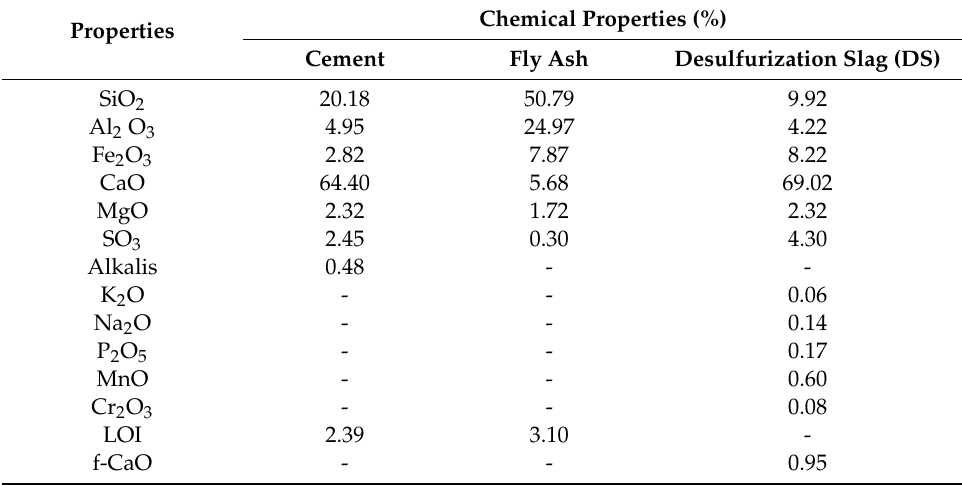
Table 1. The chemical properties of the